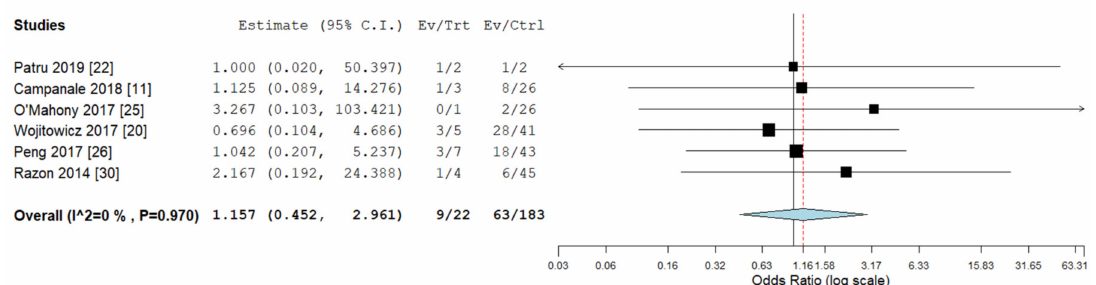
Figure 6. Pooled odd ratio (OR) for intracardiac abnormalities in right aortic arch with concomitant right ductal arch and right aortic arch with concomitant left ductal arch. (black vertical line: OR = 1, red dashed line = estimated pooled OR in the present analysis). Iˆ2: I 2 of